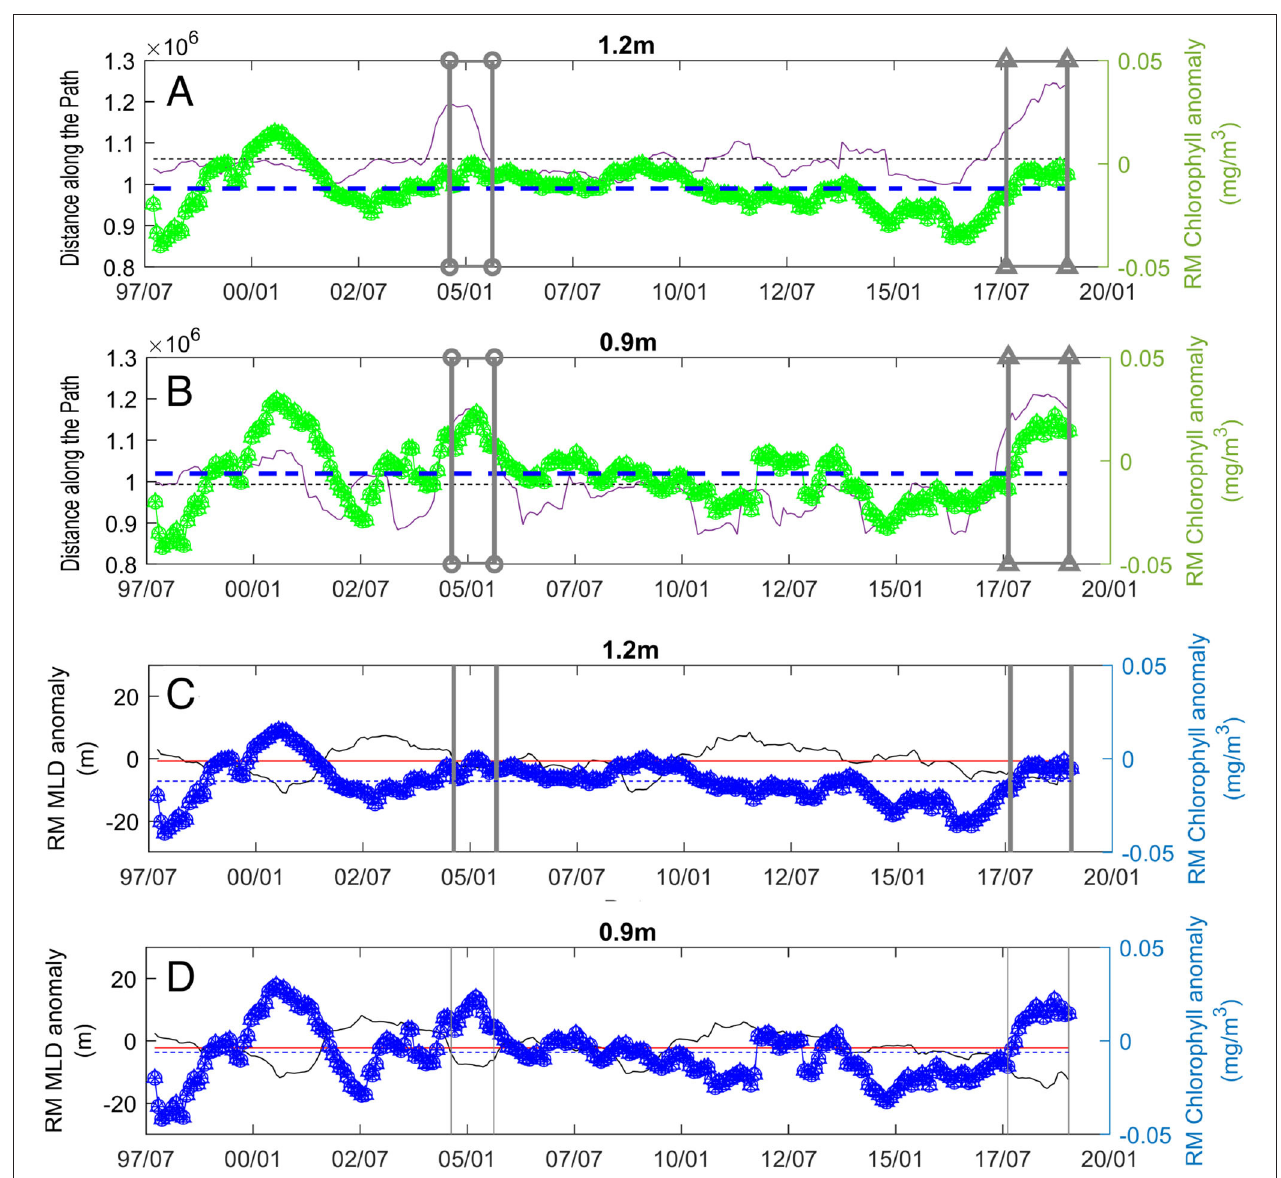
FIGURE 4 | Time series of the 13-month running-mean path length (magenta line) and the chlorophyll anomaly (green line) with different definitions of the Kuroshio axis with the SSH values for (A) 1.2 and (B) 0.9 m. Each monthly value is averaged along the path before the running average. Large meander years are enclosed in gray boxes. Blue dashed line indicates the mean chlorophyll anomaly and black dashed line indicates the mean path length. Time series of the 13-month running-mean mixed layer depth in black and chlorophyll-a anomaly in blue along the Kuroshio path with different definitions of the Kuroshio axis with the SSH values for (C) 1.2 and (D) 0.9 m. Each monthly value is averaged along the path before the running average. Large meander years are enclosed in gray boxes. Red line indicates the average mixed layer depth anomaly. Blue dashed line indicates the average chlorophyll-a